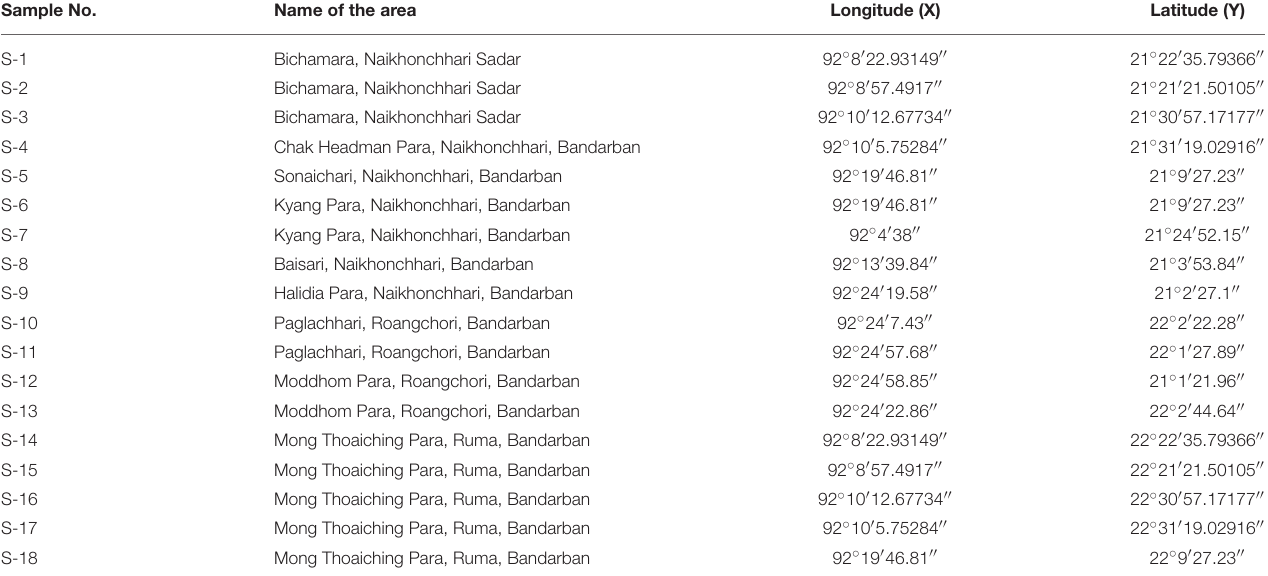
TABLE 1 | Spatial locations of collected ethnomedicinal information/plants in Bandarban district, Bangladesh. Sample